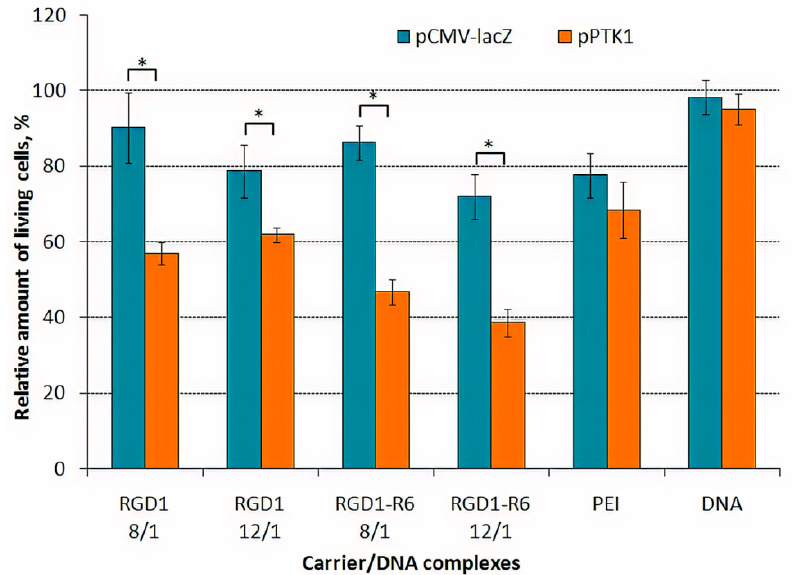
Figure 8. UL cells viability after HSV thymidine kinase expression and GCV treatment. Values are the mean ± SD of the mean of triplicates. * p < 0.05 compared to pCMV-lacZ-complexes. Similar findings were registered by the Trypan blue method allowing dead cells ex- clusion from the counting (Figure 9). The number of living cells after transfection by pCMV-lacZ-complexes did not differ from that of cells treated with GCV only. The number of viable UL cells transfected with RGD1-R6/pPTK complexes was significantly decreased up to 16–27% compared to pCMV-lacZ polyplexes. RGD1/pPTK complexes transfection also led to suicide effect resulted in reduced number of viable cells (30–42% compared to control polyplexes). PEI/pPTK1 complexes delivery led to a 1.4-fold de- crease in the amount of living cells. Importantly, the suicide effects were more pro- nounced using Trypan blue method rather than Alamar Blue assay.